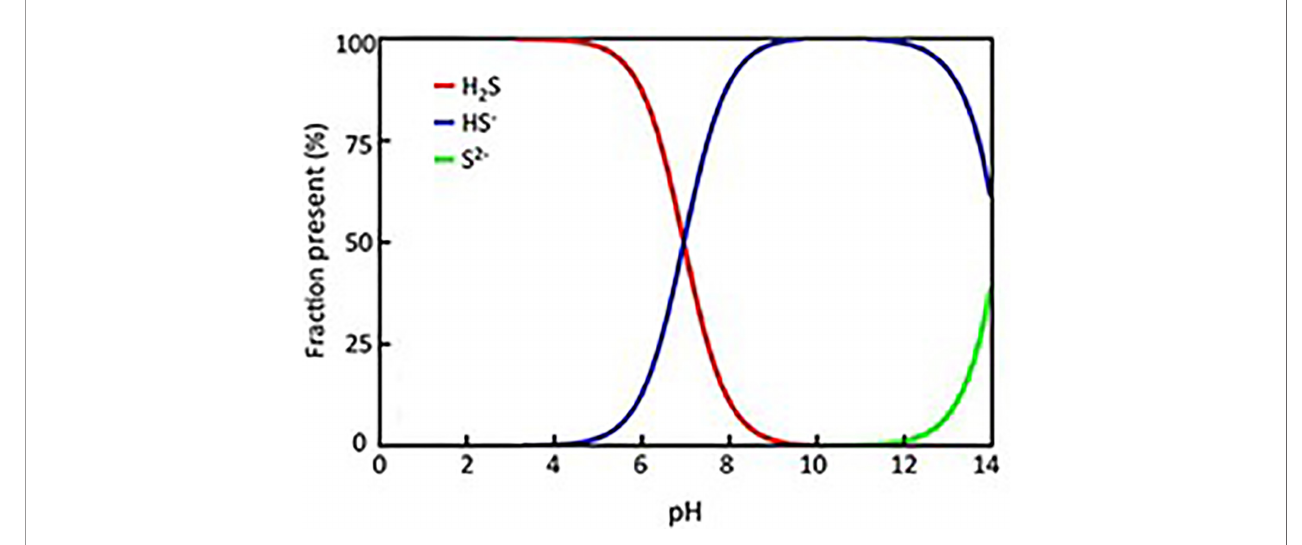
FIGURE 1 | The equilibrium speciation of aqueous hydrogen sul fi de at different pH [taken from (Holmer and Hasler-Sheetal,